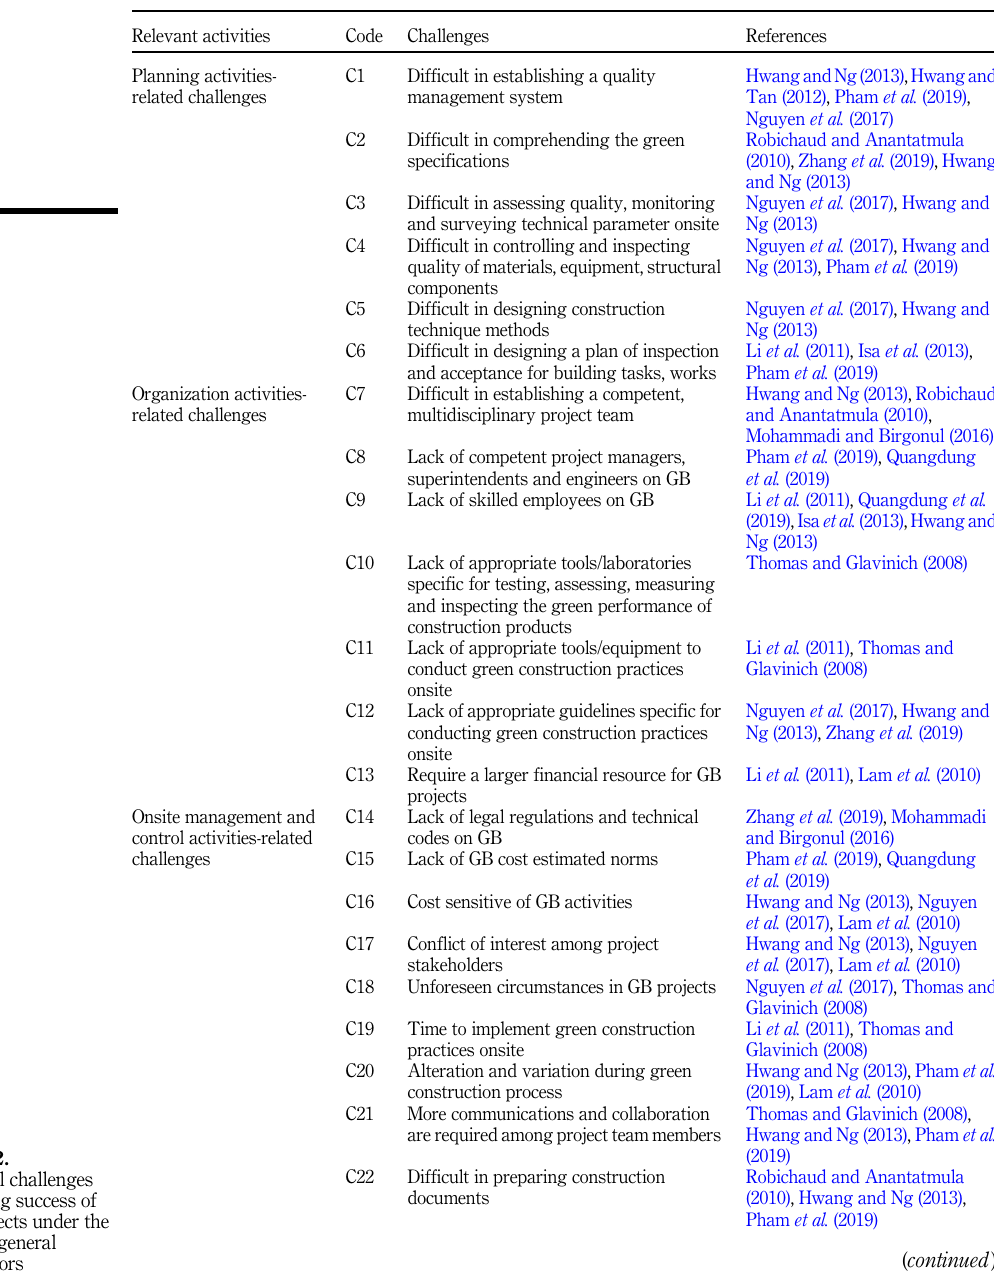
hindering success of GB projects under the view of general